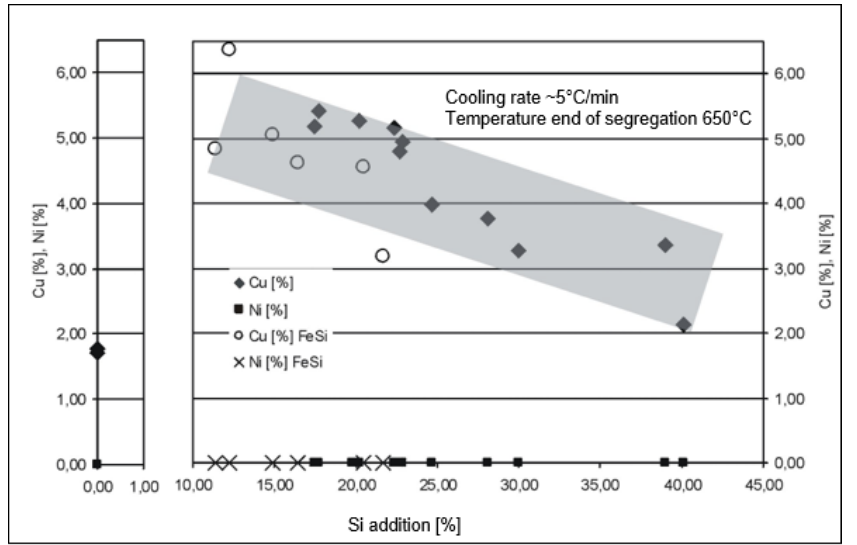
Figure 5. Final copper and nickel contents in PbSn composite as a function of the “available” silicon.